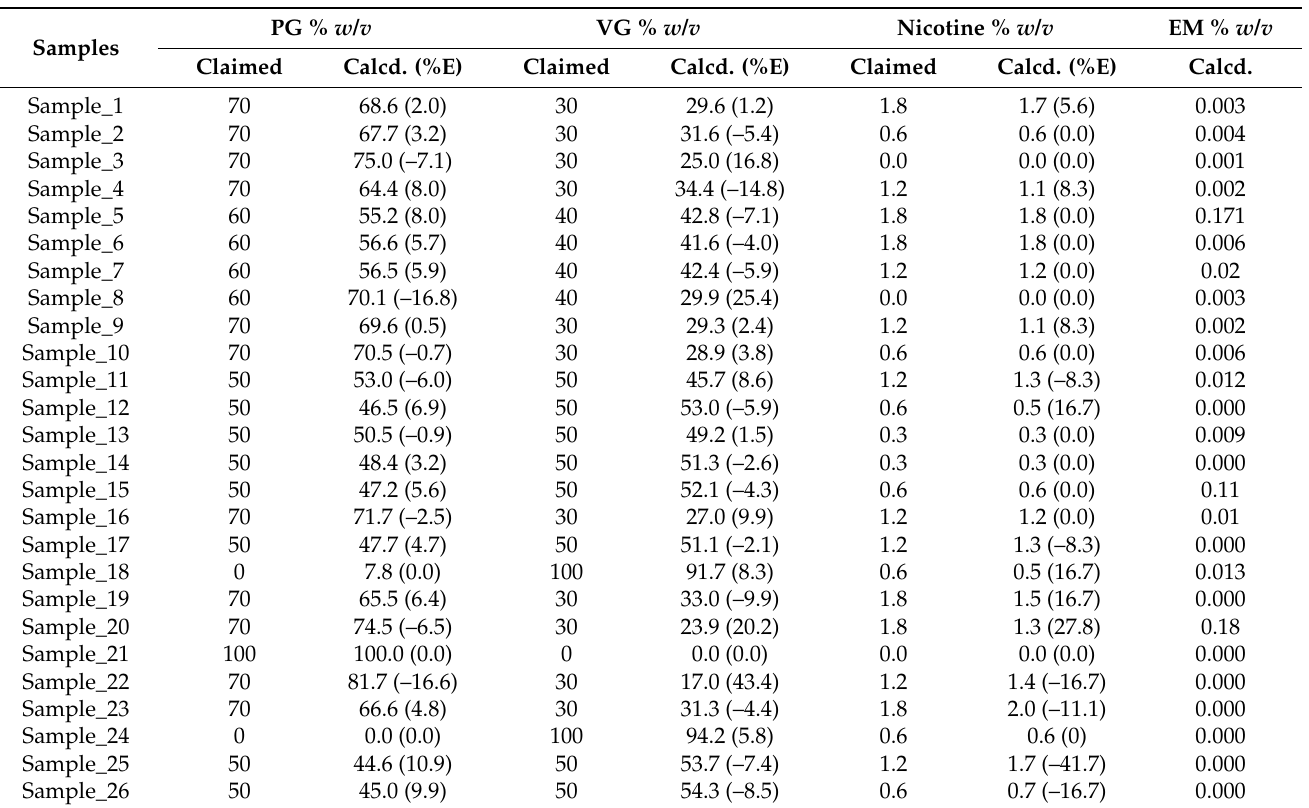
Table 3. The levels (expressed as % w / v ) of PG, VG, nicotine, and EM in the tested e-liquids calculated by the developed GC-MS methodology. The amounts of PG, VG, and nicotine claimed by the manufacturer are also presented. The error (%E) of the calculated (GC-MS–derived) vs. the claimed values is given in parenthesis. The calculation for the %E was based on the mathematical × 100. formula %E = C claimed − C calcd . C claimed